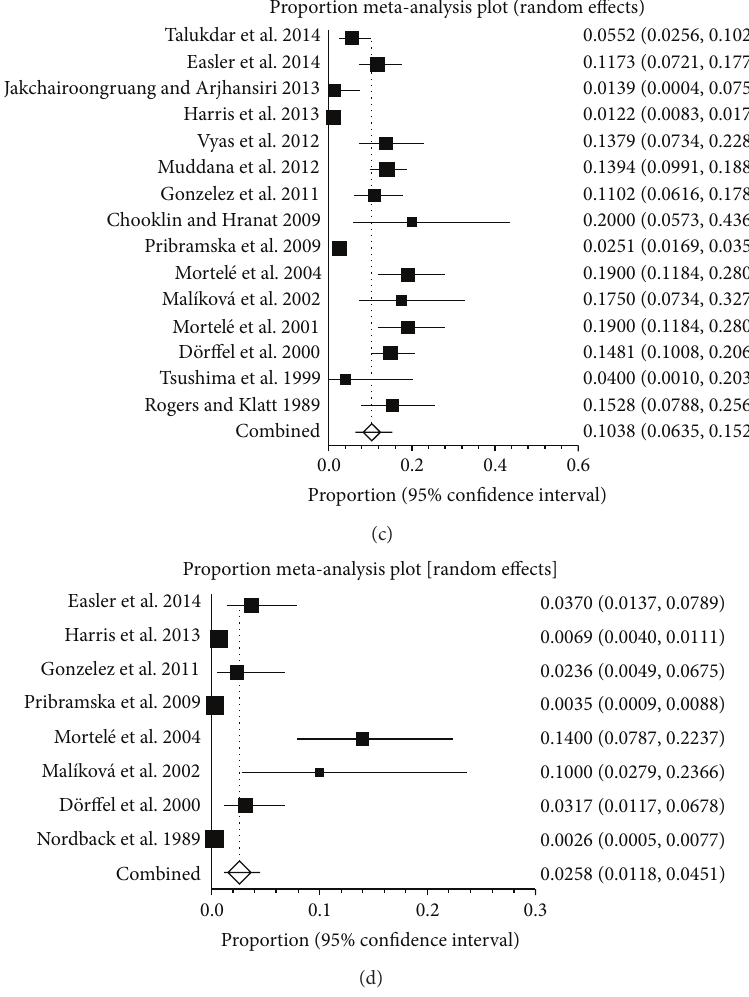
Figure 4: (a) Forest plots showing the prevalence of splanchnic vein thrombosis (SVT) in acute pancreatitis (AP). (b) Forest plots showing the prevalence of portal vein thrombosis (PVT) in acute pancreatitis (AP). (c) Forest plots showing the prevalence of splenic vein thrombosis (SlpVT) in acute pancreatitis (AP). (d) Forest plots showing the prevalence of mesenteric vein thrombosis (MVT) in acute pancreatitis